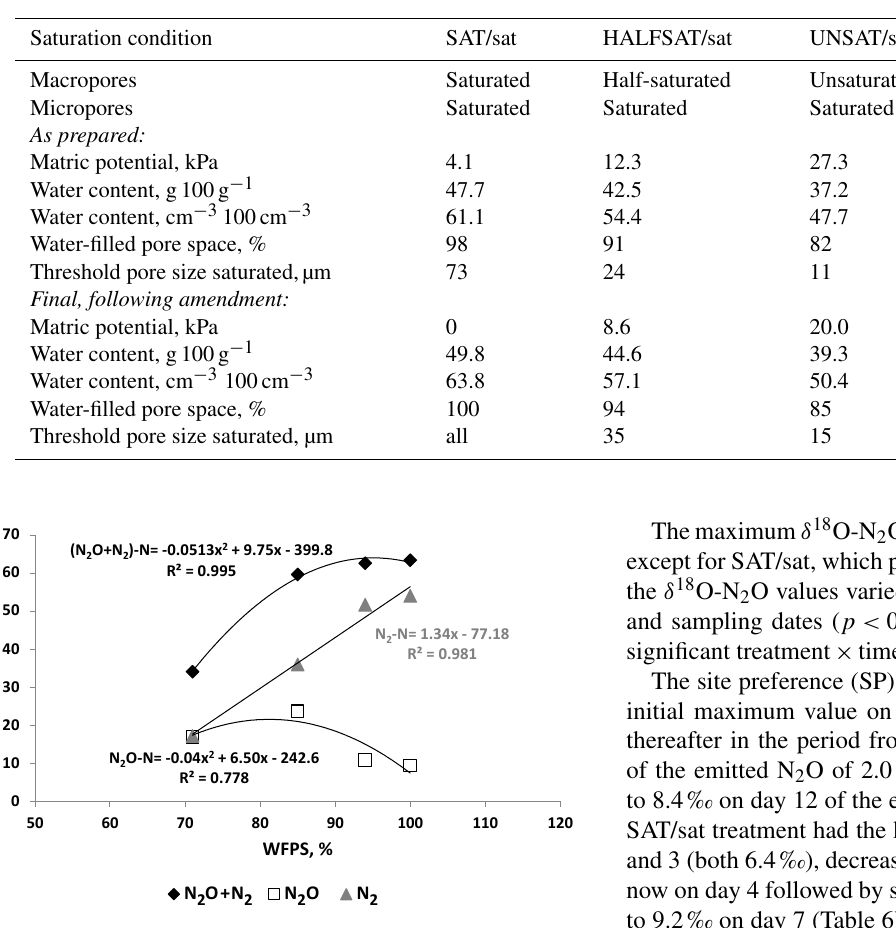
Figure 2. Total N emissions (N 2 O + N 2 ) -N, N 2 O and N 2 vs. WFPS. Fitted functions through each dataset are also